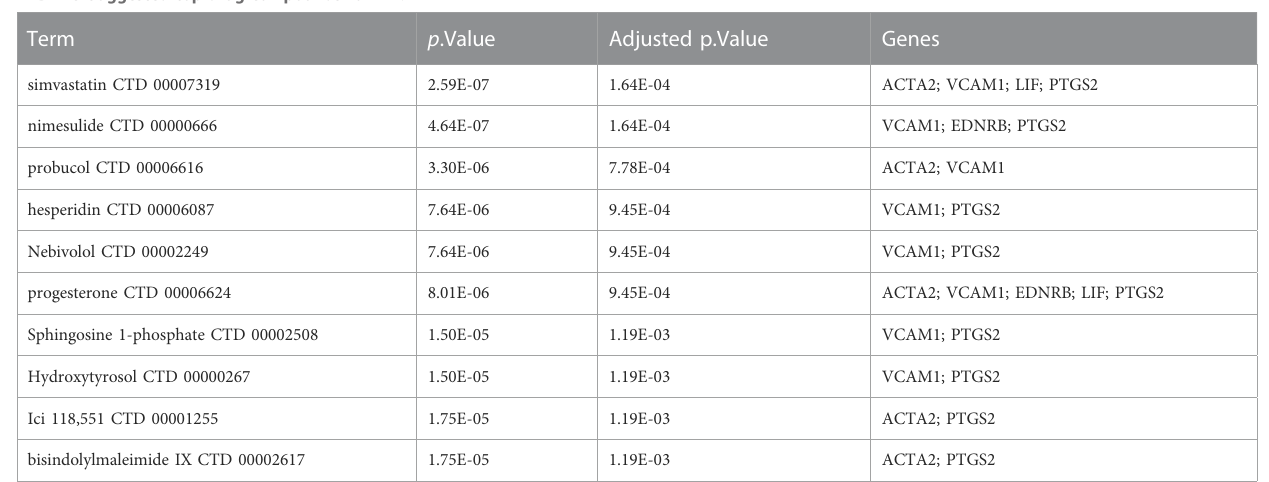
TABLE 3 Suggested top drug compounds for